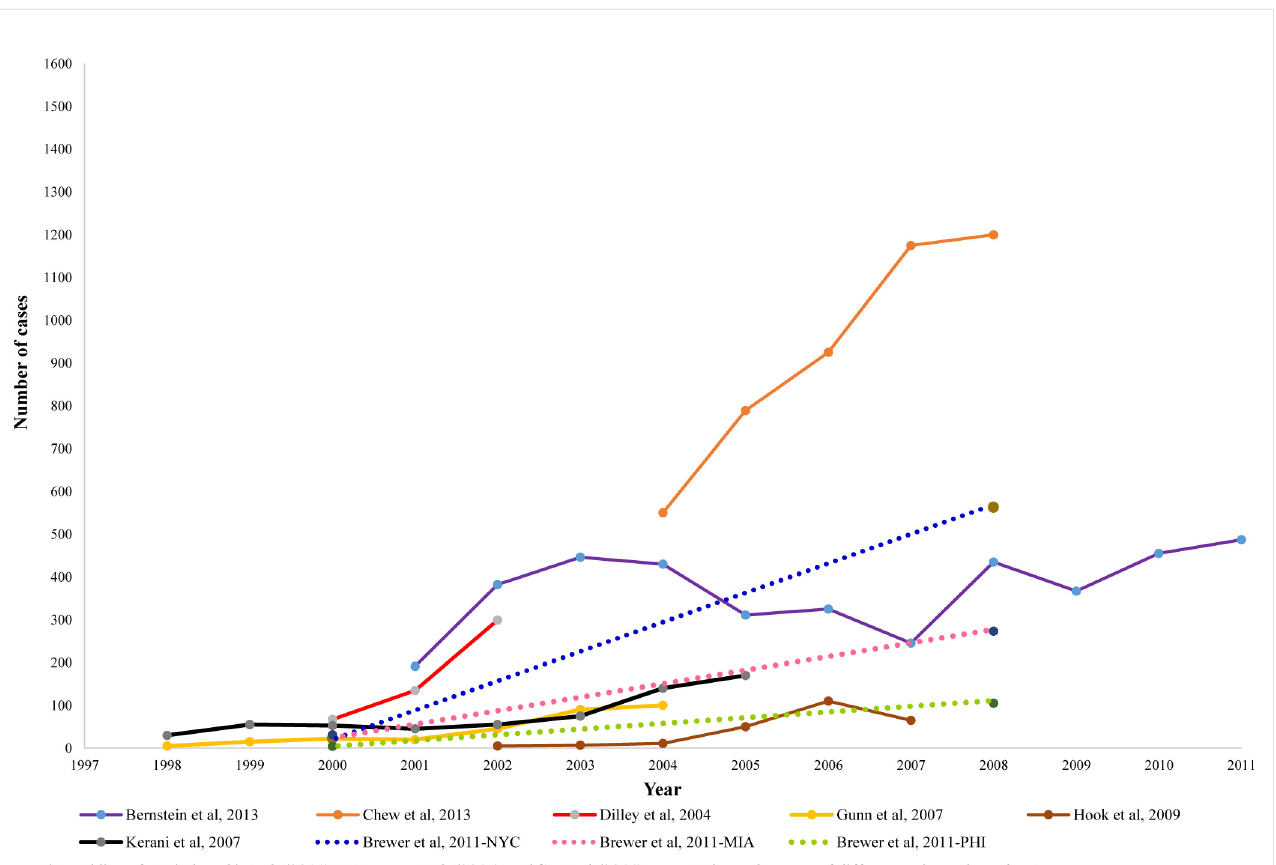
Fig 2. Syphilis trend studies in the United States: annual number of syphilis cases among MSM, 2004 – 2011.